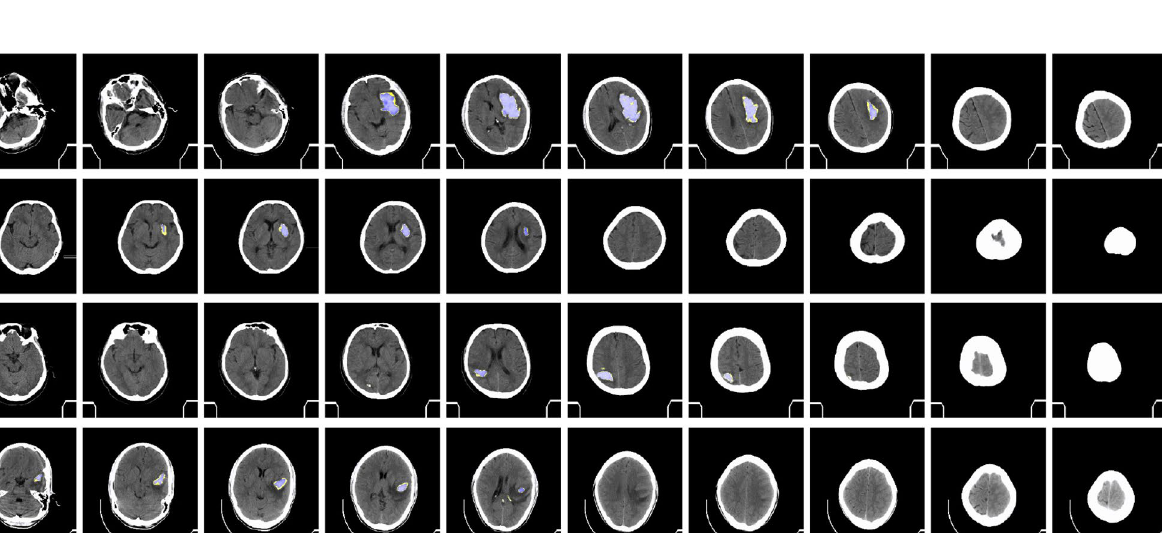
Table 3. Performance comparison between GroupCapsNet and existing methods in intracranial hemorrhage segmentation, DPN92-Unet ensembles and GroupCapsNet ensembles methods means that training 3 models and averaging their prediction results.